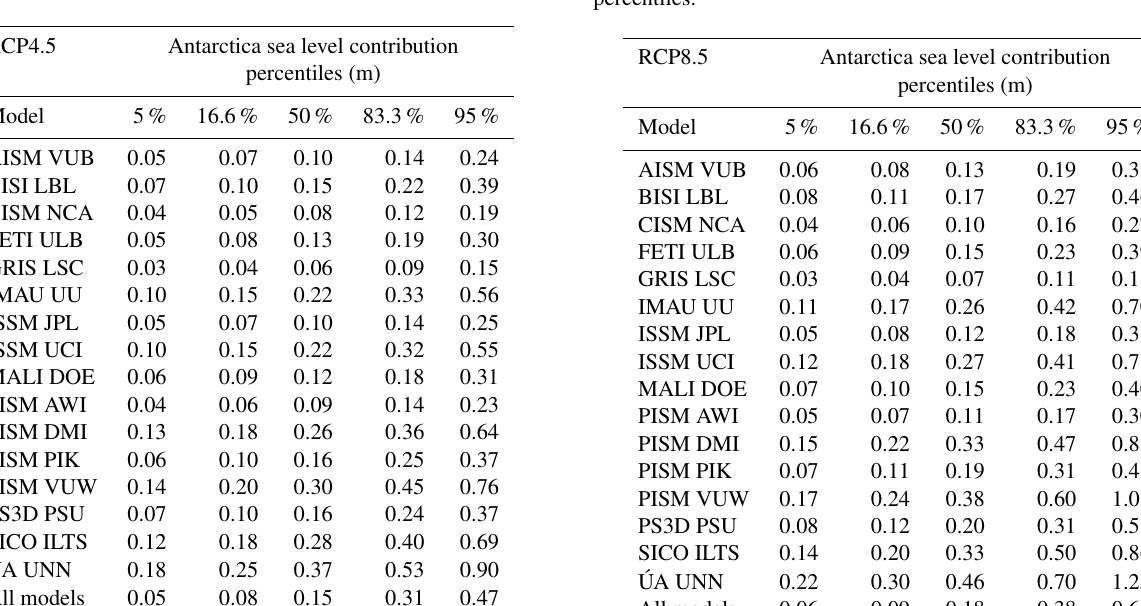
Table 8. Percentiles of the probability distribution of the sea level contribution of Antarctica for different ice sheet models under the RCP4.5 climate scenario. The 50th percentile corresponds to the median; 16.6%–83.3% is the so-called “likely range” as denoted in the IPCC reports. The “very likely range” is given by 5%–95%.